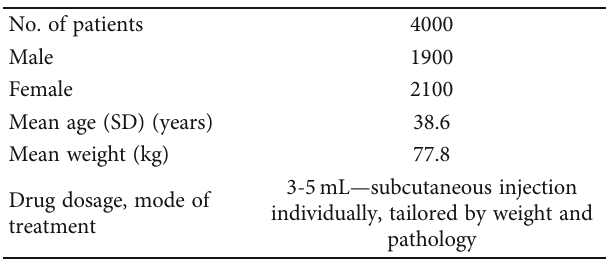
3-5mL — subcutaneous injection